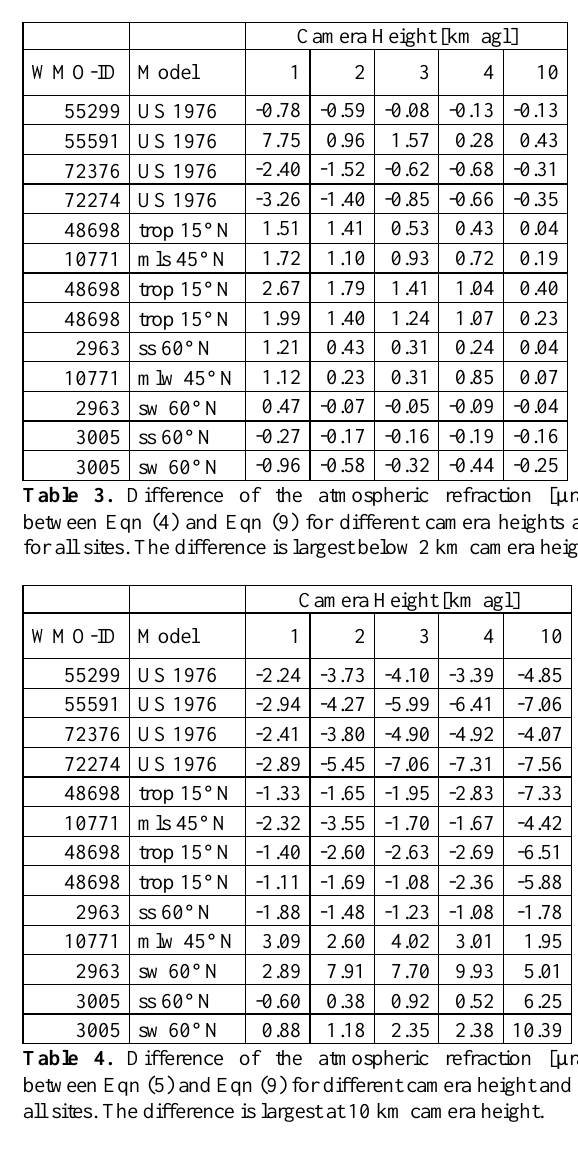
Table 2. Atmospheric refraction [ μ rad] for different camera height over ground calculated from the radiosonde profiles of all sites using Eqn (9).